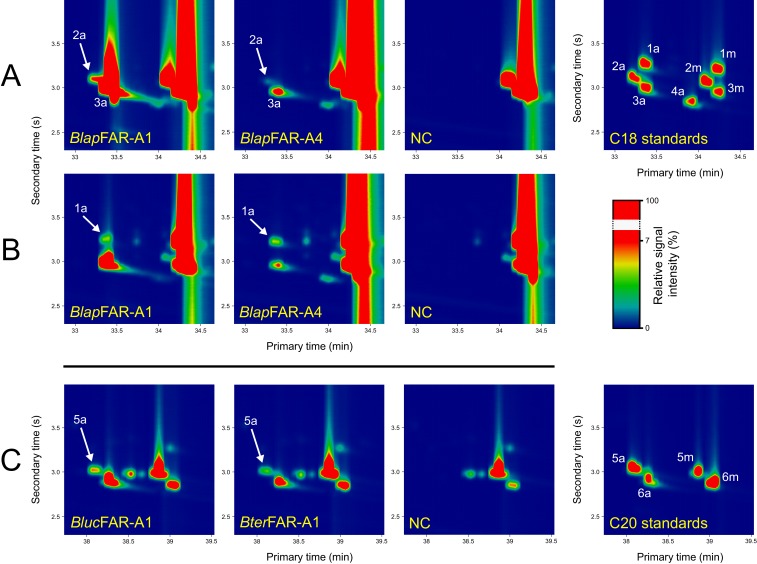
Fatty alcohol production in FAR-expressing yeasts supplemented with non-native fatty acyl substrates.Following GC×GC-MS chromatogram traces show the production of fatty alcohols by BlapFAR-A1, BlapFAR-A4, BlucFAR-A1 and BterFAR-A1 determined in extracts from yeast strains supplemented with Z9,Z12-18: (A), Z9,Z12,Z15-18: (B) and Z15-20: (C) acyl precursors, that is the acyls which are non-native to the yeast. NC, negative control (yeast carrying empty vector); 1a, Z9,Z12,Z15-18:OH; 1 m, Z9,Z12,Z15-18:Me; 2a, Z9,Z12-18:OH; 2 m, Z9,Z12-18:Me; 3a, Z9-18:OH; 3 m, Z9-18:Me; 4a, 18:OH; 5a, Z15-20:OH; 5 m, Z15-20:Me; 6a, 20:OH; 6 m, 20:Me. The m/z values selected for display: (A) 55 + 67, (B) 55 + 79, (C) 55 + 74, standards 55 + 67 + 74 + 79.